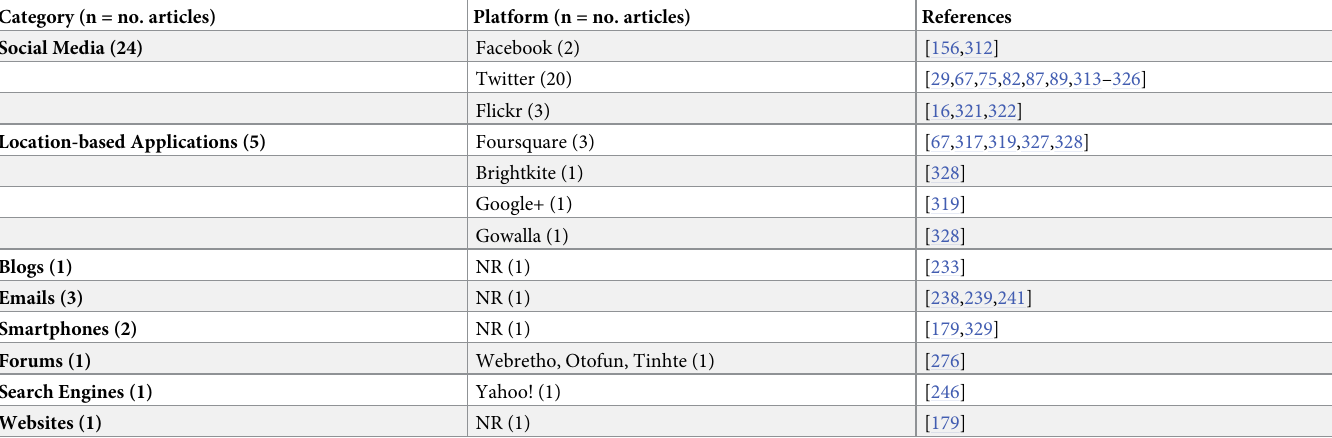
Table 5. Number of articles predicting location, with associated platforms and references.